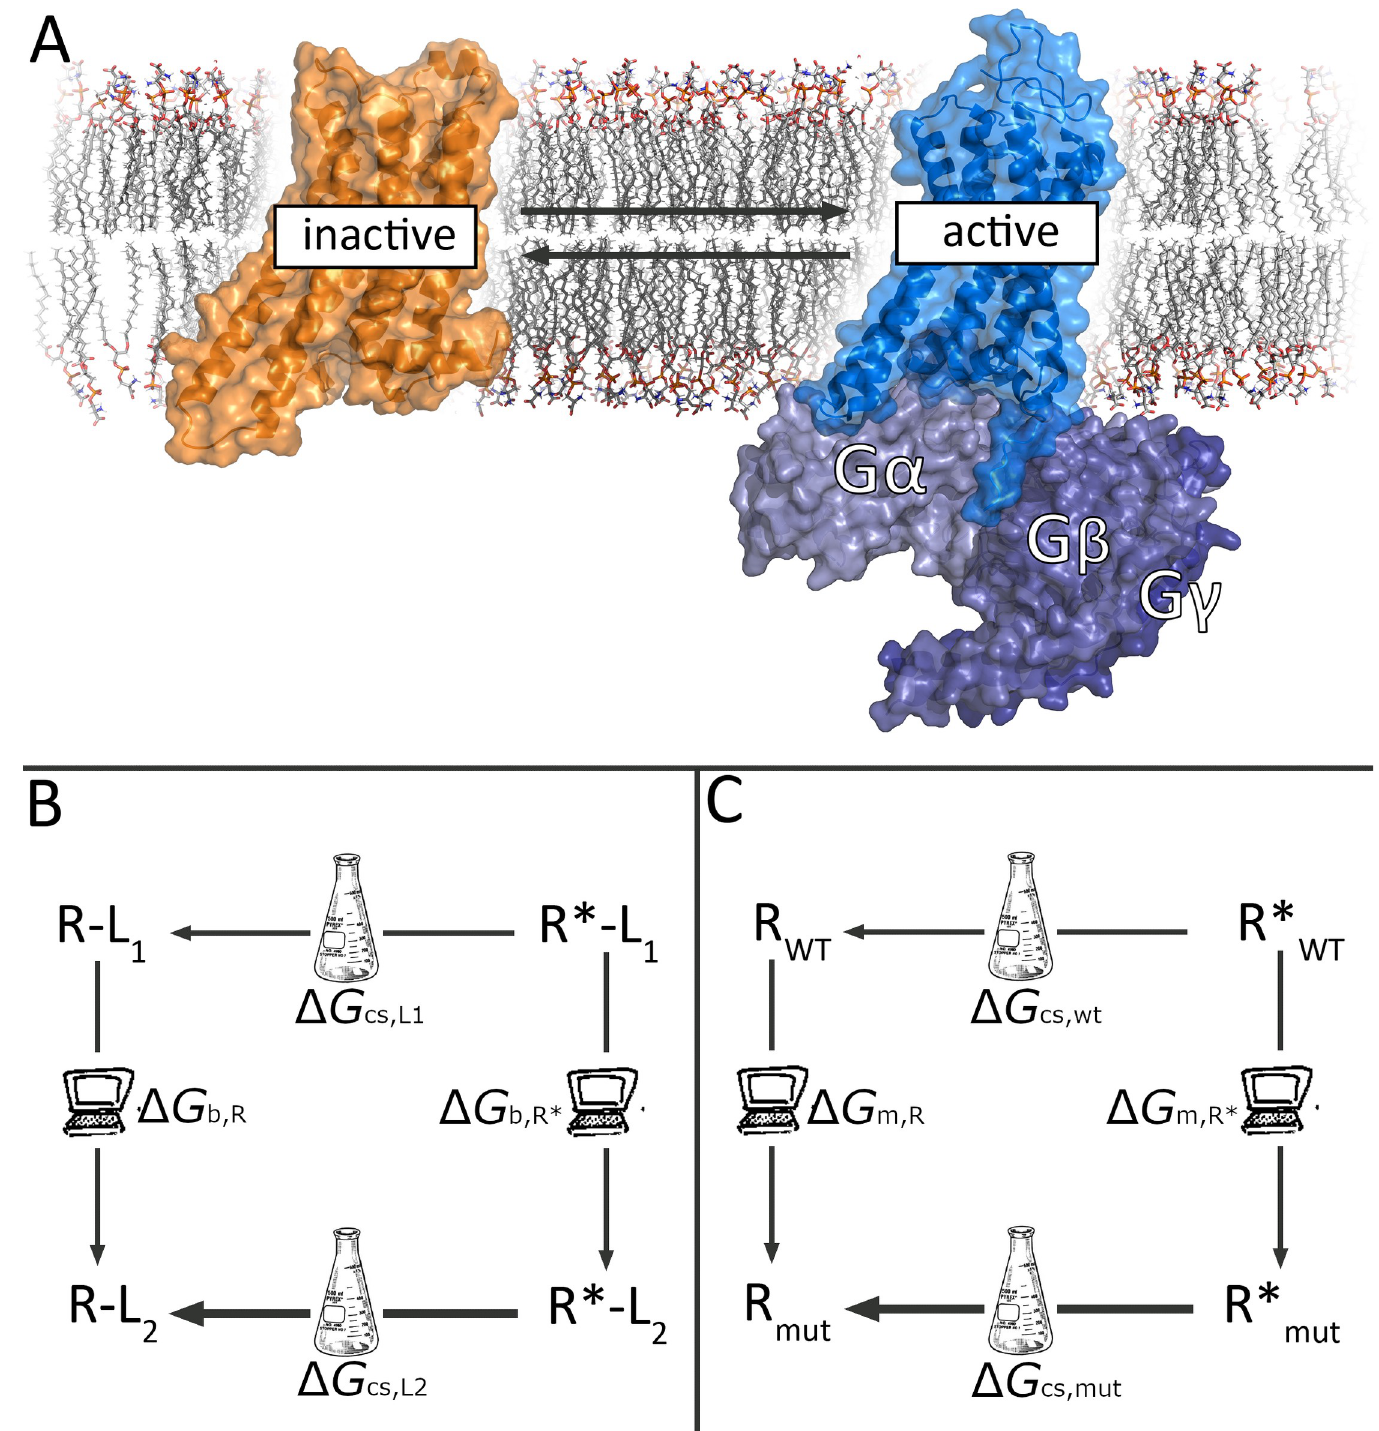
Fig 1. Thermodynamic cycles and receptor activation states. (A) Two-state model of GPCR activation between the inactive (orange) and active structure bound to a G protein (blue). (B) Thermodynamic cycle linking ligand efficacy to relative affinities for a given receptor conformation. The experimental (horizontal) legs represent the effect of a neutral antagonist (L2) on the receptor equilibrium (with no expected conformational selection, CS), and the induced shift towards the active state (R � ) due to agonist (L1) binding (represented by a thinner line towards the inactive conformation). (C) the receptor basal equilibrium can be shifted by a certain point mutation (mut), in this example a CIM that selectively stabilizes the inactive state (thicker line). Each thermodynamic cycle can be closed with vertical legs, representing the corresponding FEP calculations between the ligand pair (B) or the receptor mutation (C), allowing to estimate the differences in experimental values as the calculated difference in the FEP